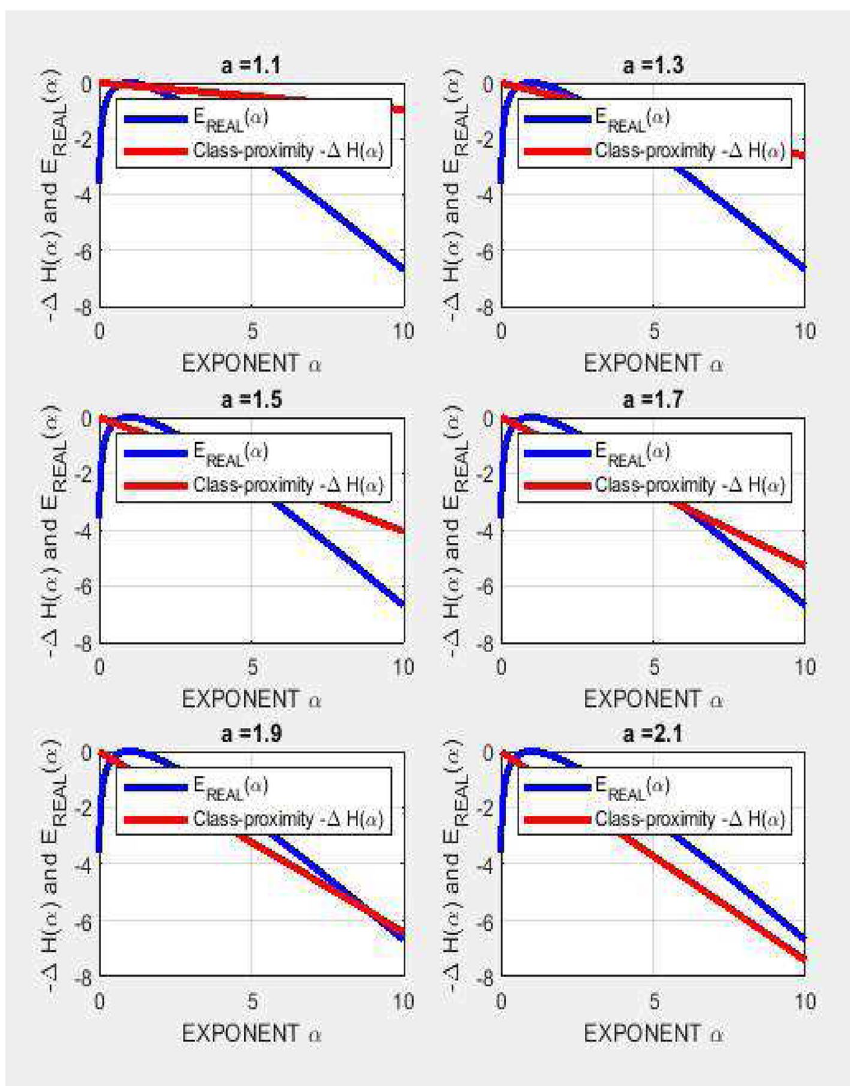
Fig. 11 The selection of the operating point, as the point of intersection towards the right of the RED and BLUE curves, to maximize class separation (not the one on the left) is shown for different values of